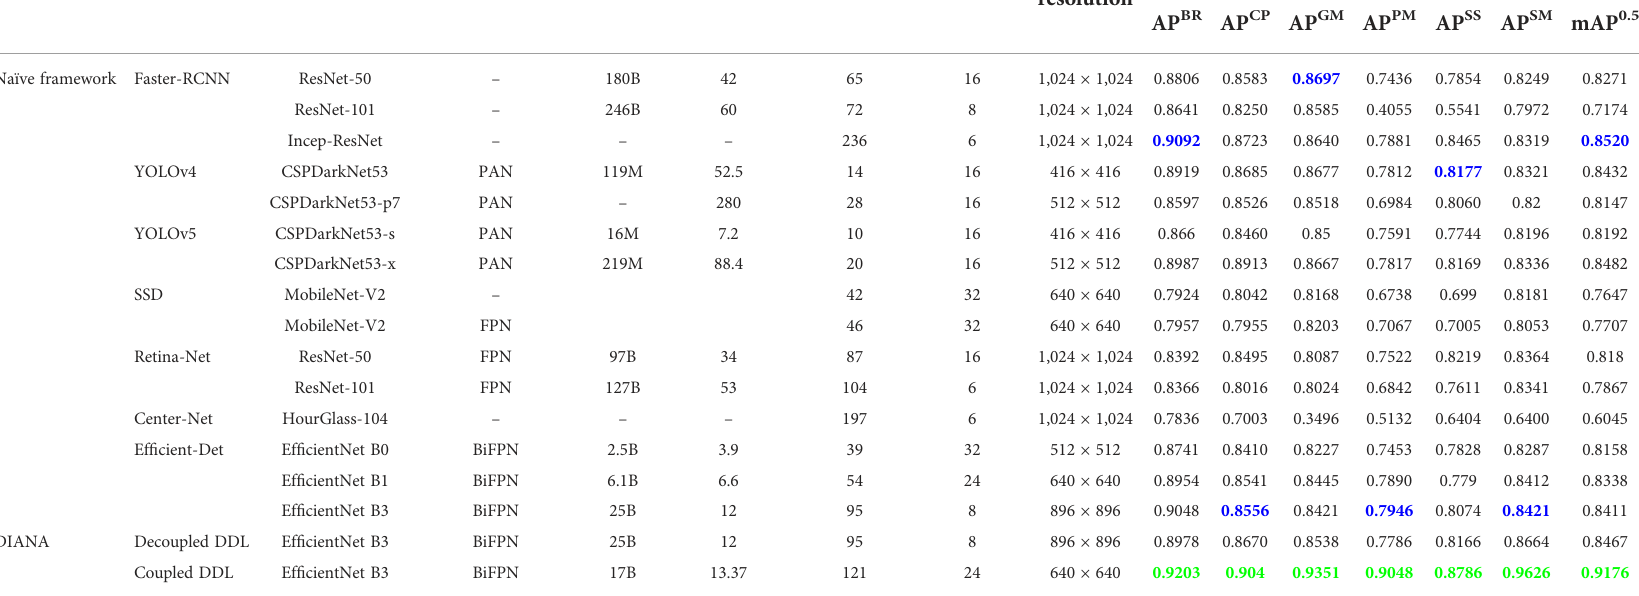
TABLE 5 DDL-unit performance on the Paprika Plant Disease Dataset (PASCAL VOC style